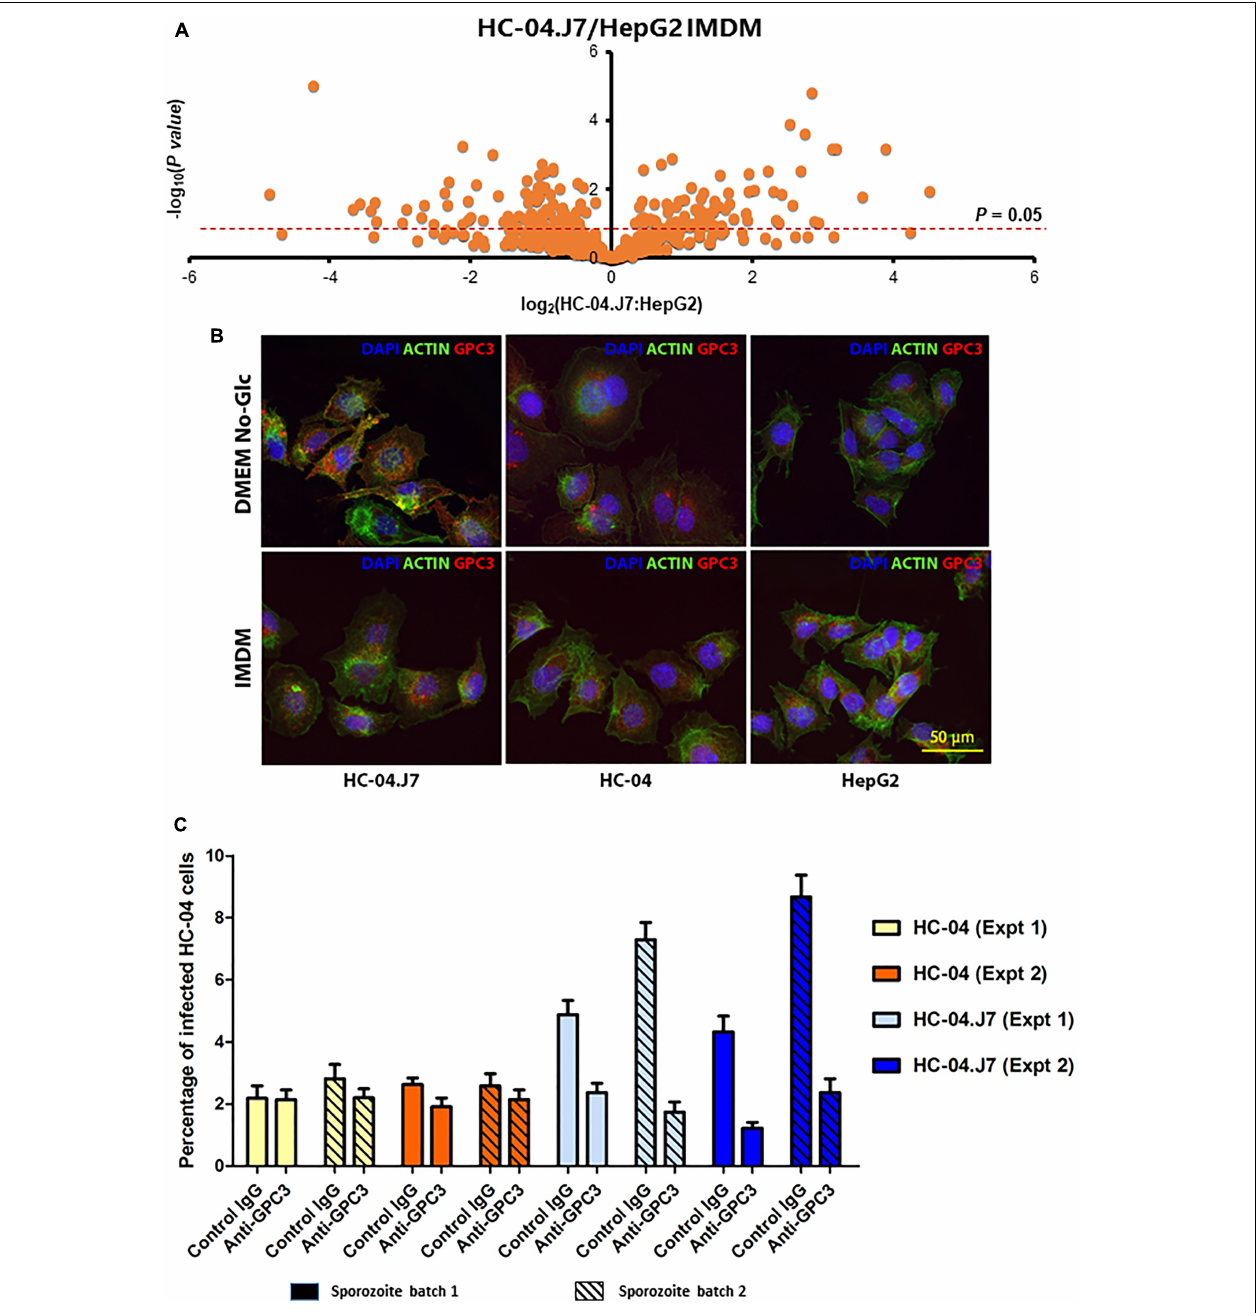
FIGURE 3 | Multi-omics analysis of HC-04, HC-04.J7, and HepG2 cell lines. (A) Volcano plot of the quantifiable surface-enriched proteome comparing HC-04.J7 protein levels to HepG2 protein levels when both cell lines are grown in IMDM. (B) Immunofluorescence staining of HC-04, HC-04.J7, and HepG2 cells grown in DMEM-NoGlc or IMDM with anti-GPC3 antibody. (C) An inhibition of liver stage development assay with anti-GPC3 antibody. Results from two representative experiments carried out using the same methodology with two different sporozoite pools with mean ± SEM are shown. A two-way ANOVA showed a significant effect of the antibody on sporozoite invasion in HC-04.J7 ( P < 0.001).